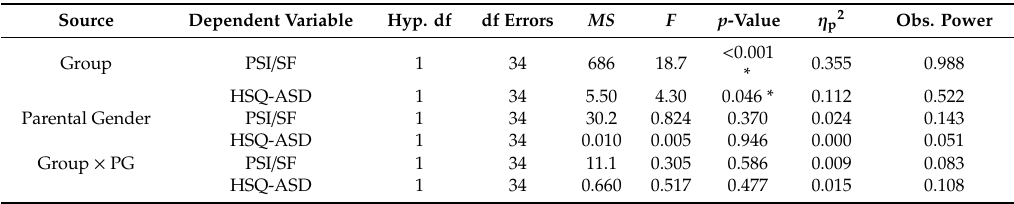
Table 3. Univariate Analysis for primary outcome